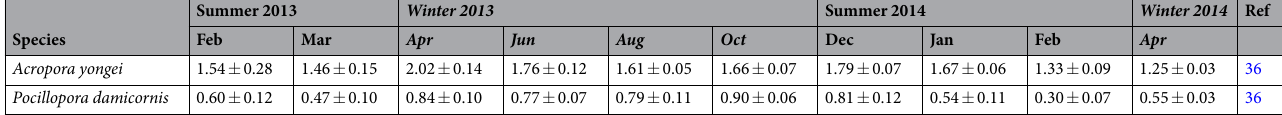
Table 2. Coral calcification rates at Rottnest Island. Seasonal changes in rates of calcification (mg cm − 2 d − 1 ; mean ± SE) for coral species ( a ) Acropora yongei , and ( b ) Pocillopora damicornis 36 . Italic denotes winter and roman areas denote